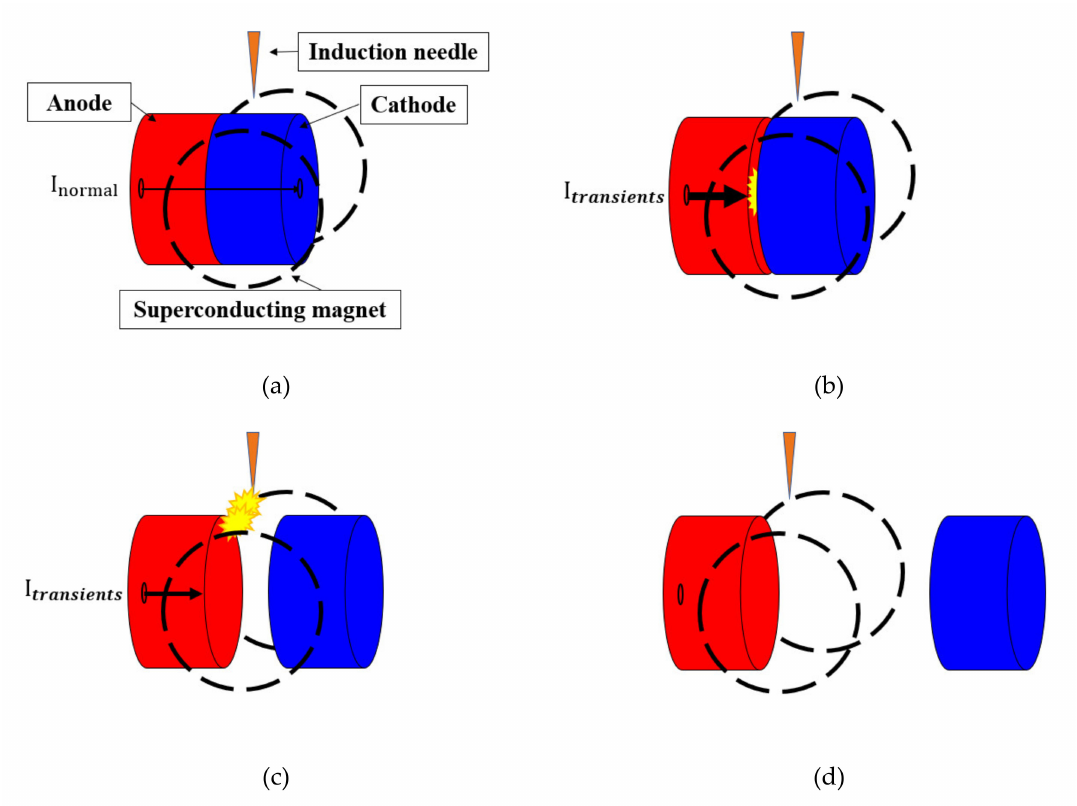
Figure 2. Operation mechanism of superconducting arc-induction type DC circuit breaker. ( a ) Normal state; ( b ) Transient state (1st); ( c ) Transient state (2nd); ( d ) Transient state